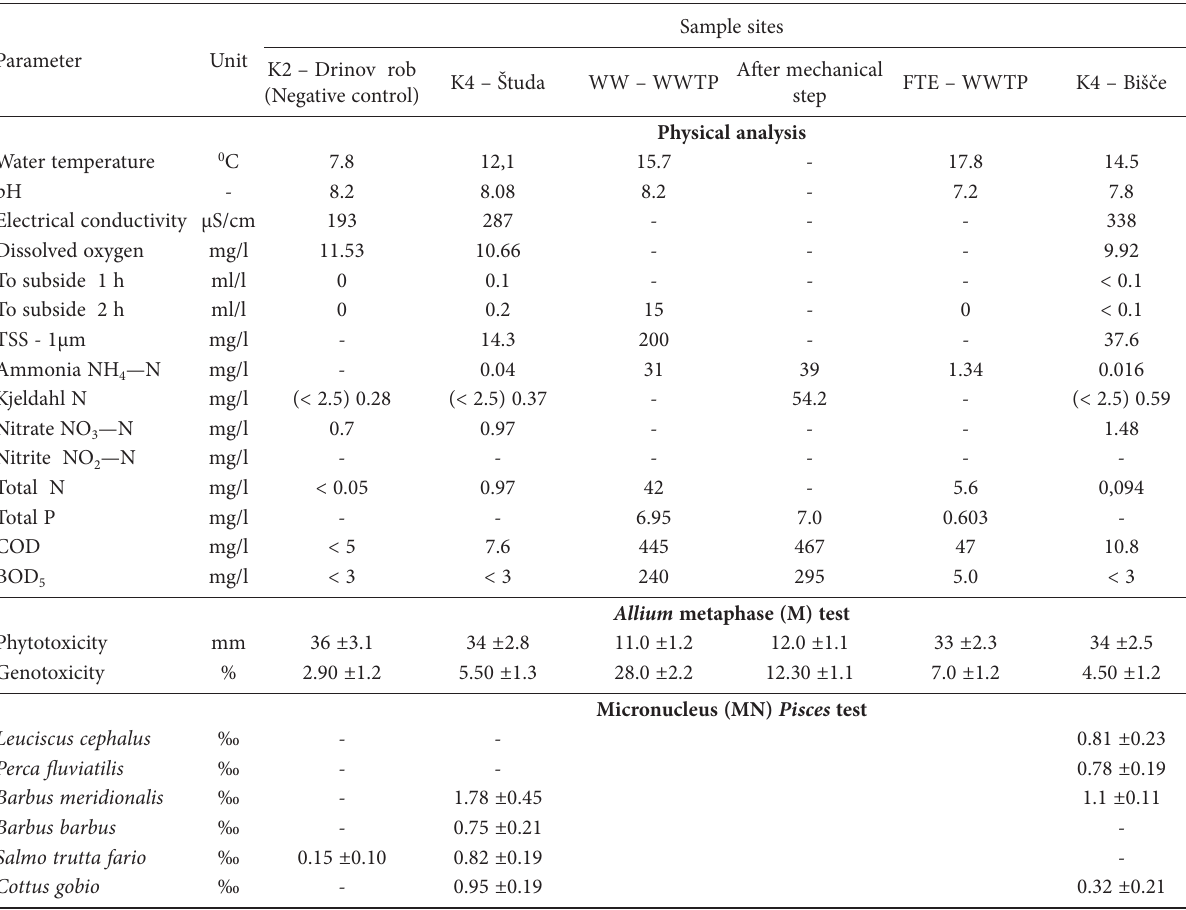
Table 4. United parameters physical quantities;cytological effects of the investigated samples survey – the genotoxicity level (damage to chromosomes) and general toxicity - phytotoxicity (root length inhibition) on the test onion plant A. cepa and Pisces micronuclei (MNi) fre- quencies in peripheral blood erythrocytes of river fish. Third sampling may